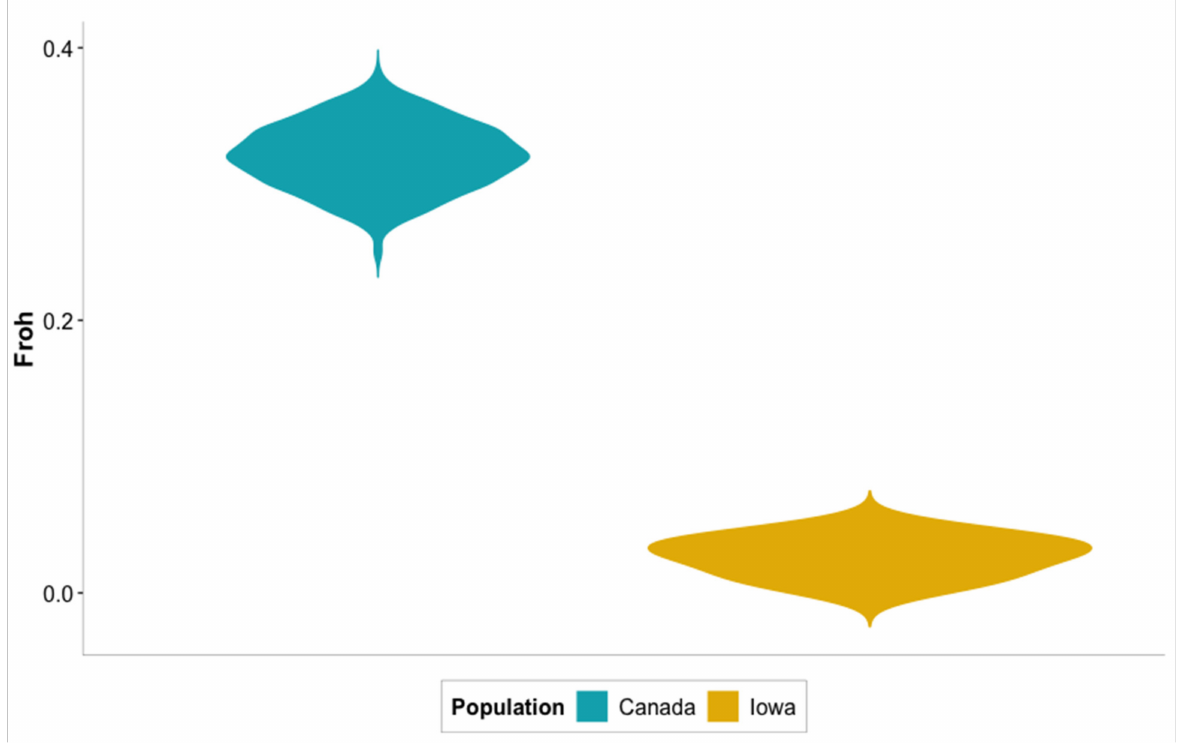
Figure 8. Distribution of inbreeding coefficients (Froh) for the populations of Iowa and